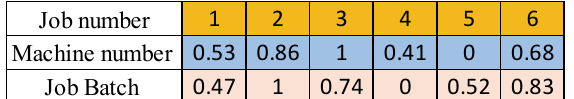
Fig. 2 The strings generated by random numbers between {0, 1} Fitness function